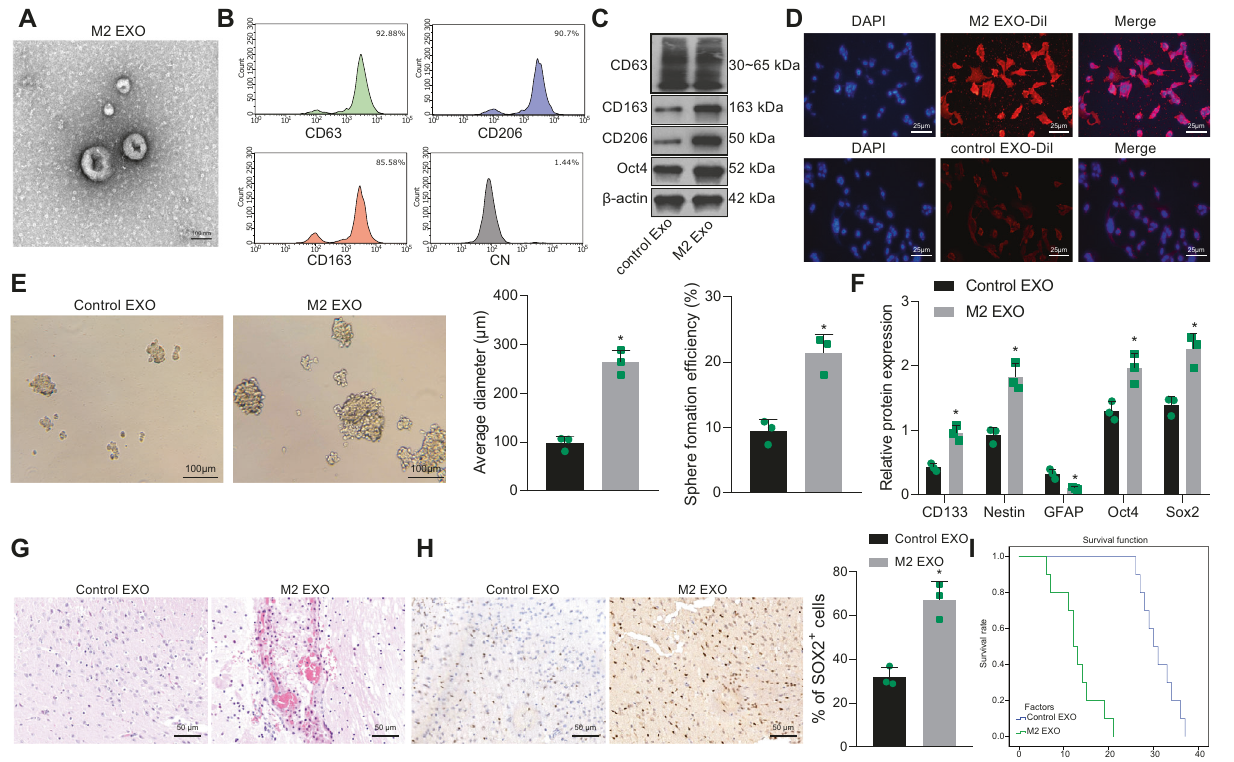
Fig. 2 M2-TAM-derived exosomes enhance the stemness of GSCs. A TEM images of M2-TAM-derived exosomes. The presence of CD63, CD206, and CD163 in M2-TAM-derived exosomes analyzed by fl ow cytometric ( B ) and Western blot ( C ) analyses. D Fluorescence images of GSCs co-cultured with Dil-labeled M2-TAM-derived exosomes with nuclei stained with DAPI (blue). E Representative images showing neurosphere formation of GSCs along with the statistics of GSC formation rate and diameter of spheres. F Expression of stem cell-related protein CD133, Nestin, Oct4, Sox2, and GFAP in GSCs measured by Western blot analysis. G HE staining images of xenograft tumors from mice. H The representative immunohistochemical images of Sox2 in xenograft tumors and the percentage of GSCs labeled by Sox2. I Kaplan – Meier survive curve of tumor-bearing mice. n = 10. * p < 0.05 vs. the control EXO group. Measurement data were depicted as mean ± standard deviation, comparison of that between two groups was conducted by unpaired t test. Cell experiments were repeated three times